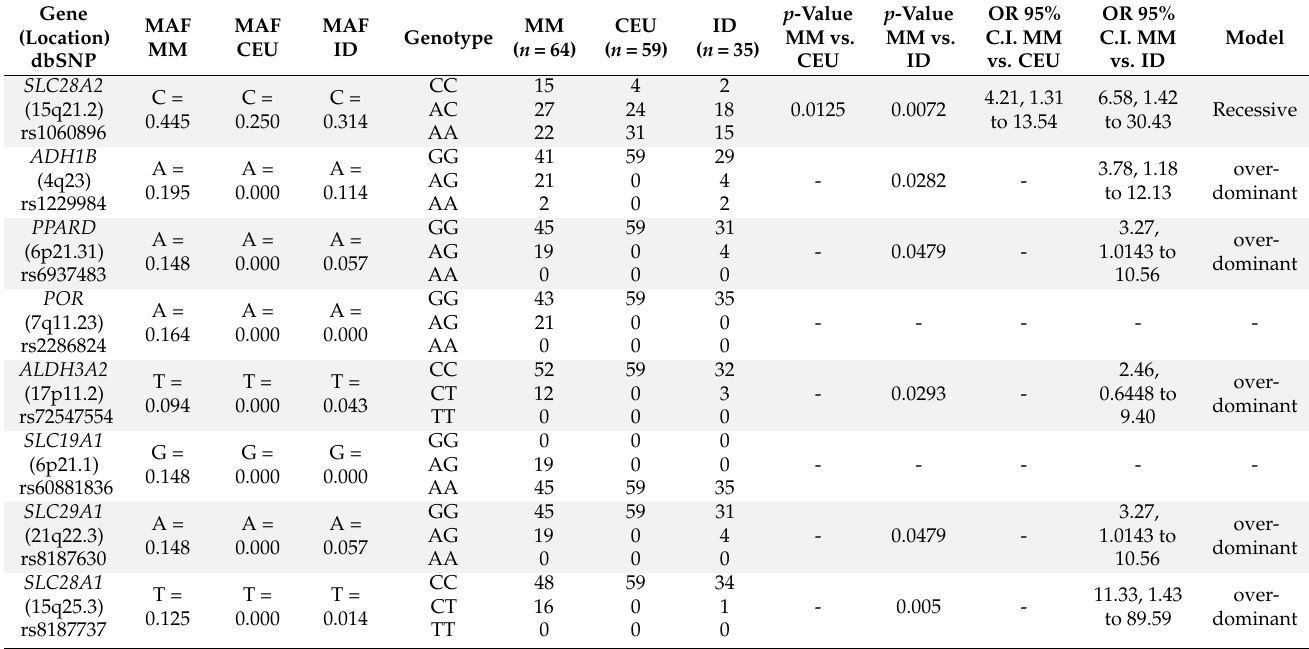
Table 1. Summary results for SNPs associated with MM